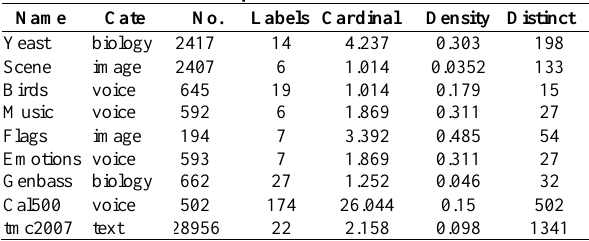
Table 2. Datasets used in experiments along with their